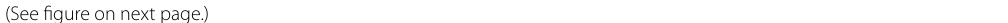
(See figure on next Fig. 9 a Schematic showing locations of proposed sources for Phase 1 and Phase 2 under Taal Volcano and the location of tiltmeter DAK. Leveling lines performed by PHIVOLCS are shown as black dashed lines. b Calculated tilt at DAK during Phase 1 (April to June 11, 2010, Phase 1 in Fig. 8) from an inflation source at a depth of 5 km. The surface projection of this source is 1 km to the east of DAK. See text for source details. c Calculated tilt at DAK during Phase 2 (June 11 to July 13, 2010, Phase 2 in Fig. 8) from an inflation source at a depth of 2.5 km. The surface projection of this source is 1 km to the south of DAK under the MCL . See text for source details